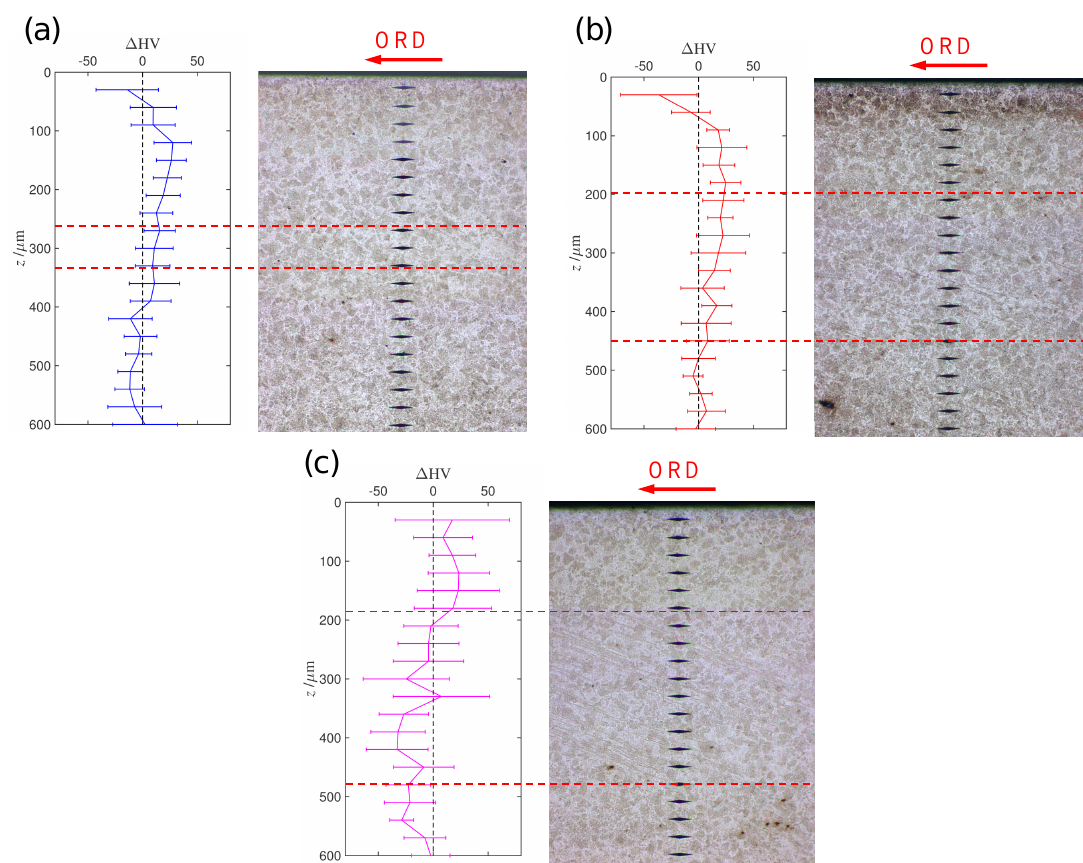
Figure 3. Hardness profiles and corresponding OM images for the samples run to ( a ) 5 × 10 8 , ( b ) 1 × 10 9 and ( c ) 2 × 10 9 cycles.